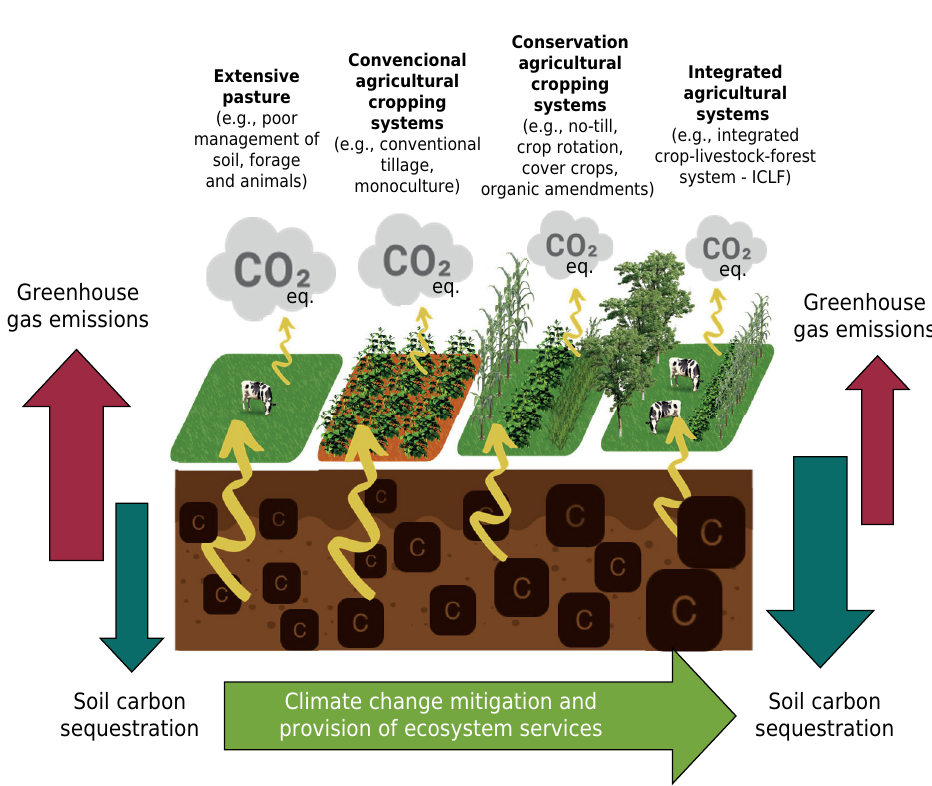
Figure 6. Conceptual framework of soil C sequestration and some of its additional benefits in areas of Brazilian Cerrado under climate-smart agriculture practices.